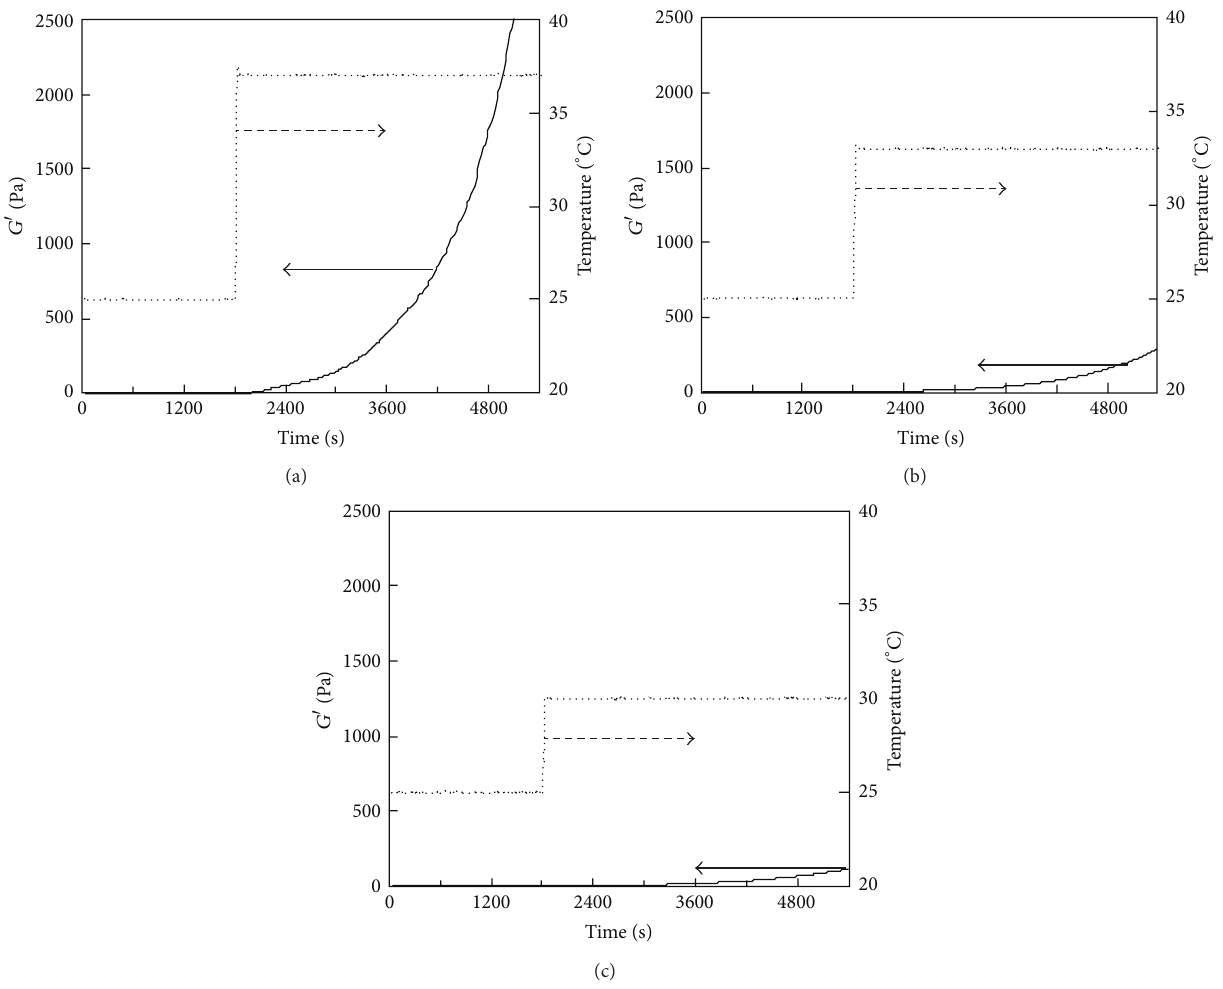
Figure 5: Storage modulus ( G 󸀠 ) of the 0.5% PSC/1mM genipin solution measured by a temperature-responsive gelation test. The temperature was maintained at 25 ∘ C for 1800 s and then increased to (a) 37, (b) 33, or (c) 30 ∘